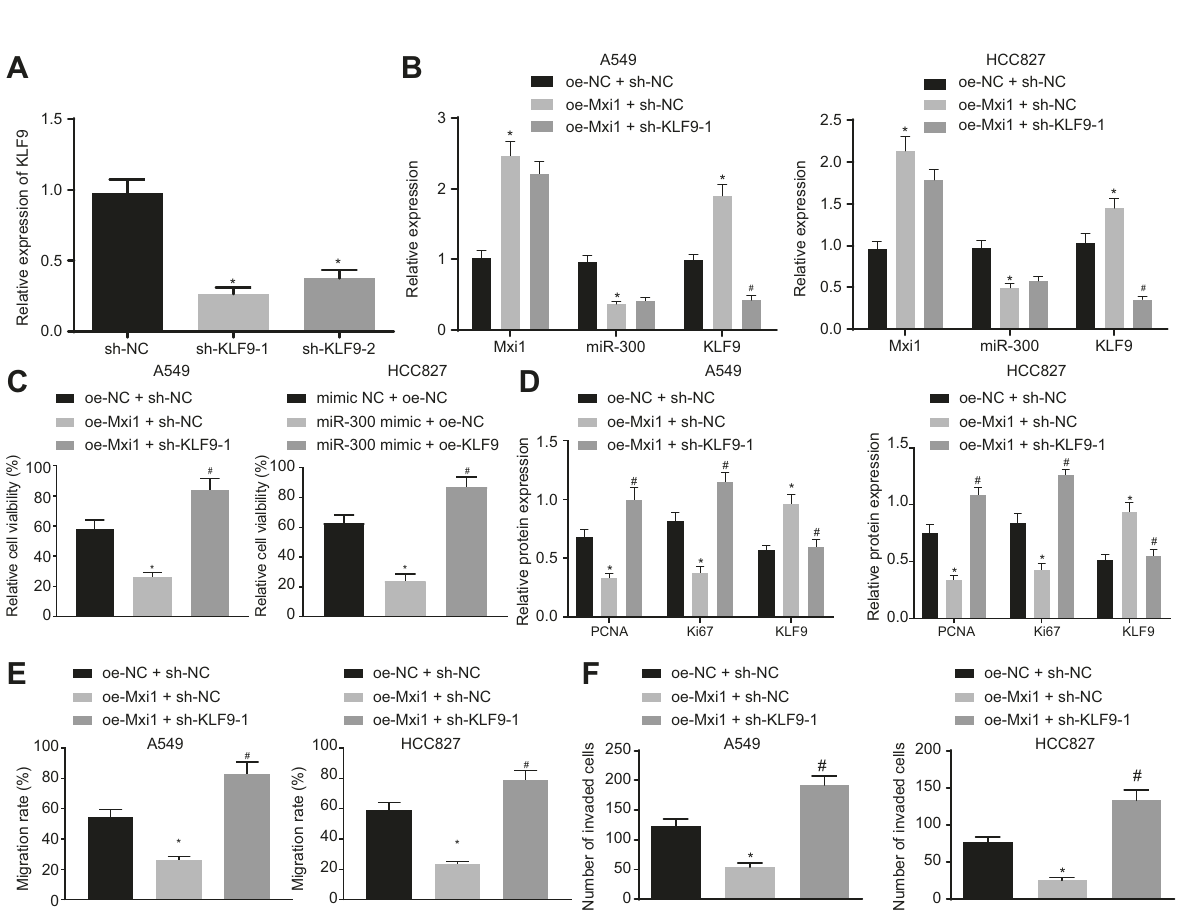
Fig. 5 Mxi1 elevation suppresses the malignant phenotype of lung cancer cells through the miR-300/KLF9 axis. A Result of RT-qPCR evaluating the knockdown ef fi ciency of KLF9 shRNAs. * p < 0.05, vs. sh-NC. B Result of RT-qPCR detecting the expression of Mxi1, miR-300, and KLF9 in A549 and HCC827 cells. C Result of FACS evaluating cell viability of A549 cells and HCC827 cells under indicated conditions. D Western blot analysis detecting the protein expression of KLF9, Ki67, and PCNA in A549 cells and HCC827 cells under indicated conditions. E Scratch assay evaluating the migration ability of A549 cells and HCC827 cells under indicated conditions. F Transwell invasion assay investigating the invasion potency of A549 cells and HCC827 cells under indicated conditions. B – F * p < 0.05, vs. oe-NC + sh-NC, # p < 0.05, vs. oe-Mxi1 + sh-NC. Cell experiments were conducted three times independently. signi fi cantly impaired in mice receiving GADD34-silenced HCC827 the depletion of GADD34 by RT-qPCR. The sh-GADD34-1 with the cells while concomitant silencing of KLF9 and GADD34 promoted most signi fi cantly silenced GADD34 expression was selected for the tumor growth (Fig. 7D). Moreover, the results of immunohis- subsequent analysis (Fig. 7A). In A549 and HCC827 cells, silencing tochemistry demonstrated that the protein expression of GADD34, of GADD34 reduced cell viability and proliferation while further Ki67 and PCNA was signi fi cantly reduced, with no signi fi cant silencing of KLF9 augmented cell viability and proliferation (Fig. difference in that of Mxi1 and KLF9 in tumor tissues of mice 7B, C). These data suggested that knockdown of KLF9 could receiving GADD34-silenced HCC827 cells relative to that of sh- reverse the inhibitory effect of GADD34 knockdown on lung negative control (NC). Concomitant silencing of KLF9 and GADD34 cancer cell viability, thereby promoting lung cancer tumor growth. led to no changes in the Mxi1 protein expression, lower KLF9 Next, we conducted orthotopic implantation of HCC827 cells in protein expression and higher protein expression of GADD34, Ki67 C57BL/6 mice to establish a lung tumor model. Tumor growth was Cell Death and Disease (2022)